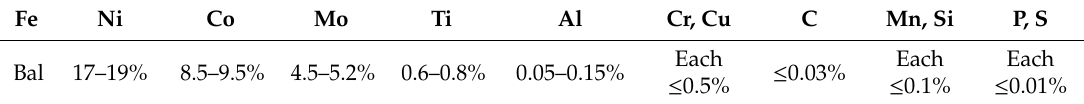
Table 4. Chemical composition of maraging steel (st-%) [31].